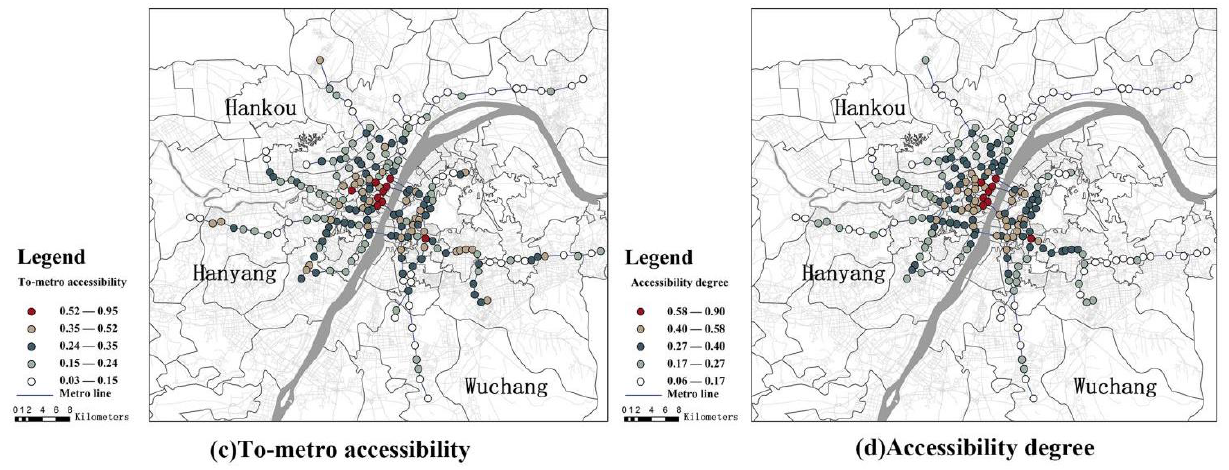
Figure 4. Spatial patterns of different sub-indices, including ( a ) ‘by-metro’, ( b ) ‘land-use’, ( c ) ‘to-metro’, as well as ( d ) the integrated accessibility index.